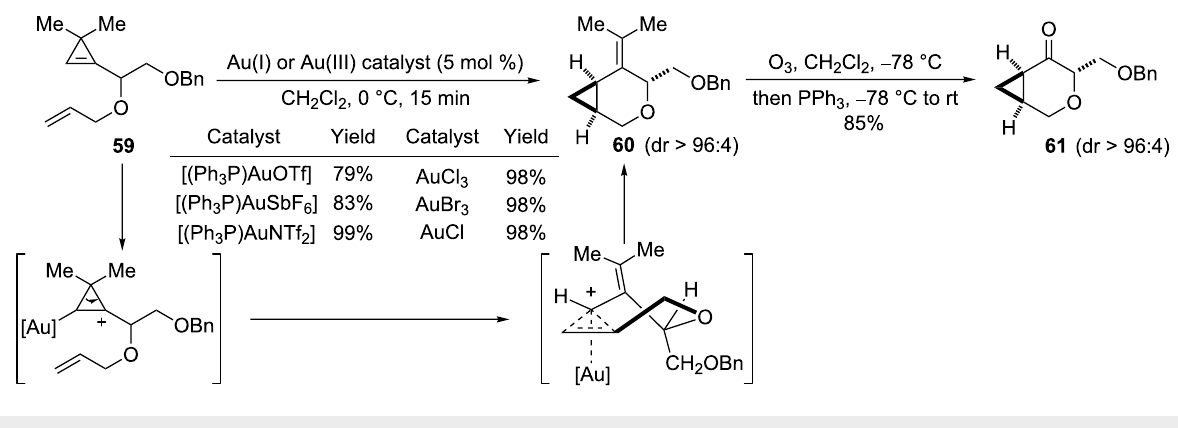
Scheme 26: Gold-catalyzed cycloisomerization of cyclopropene-ene 59